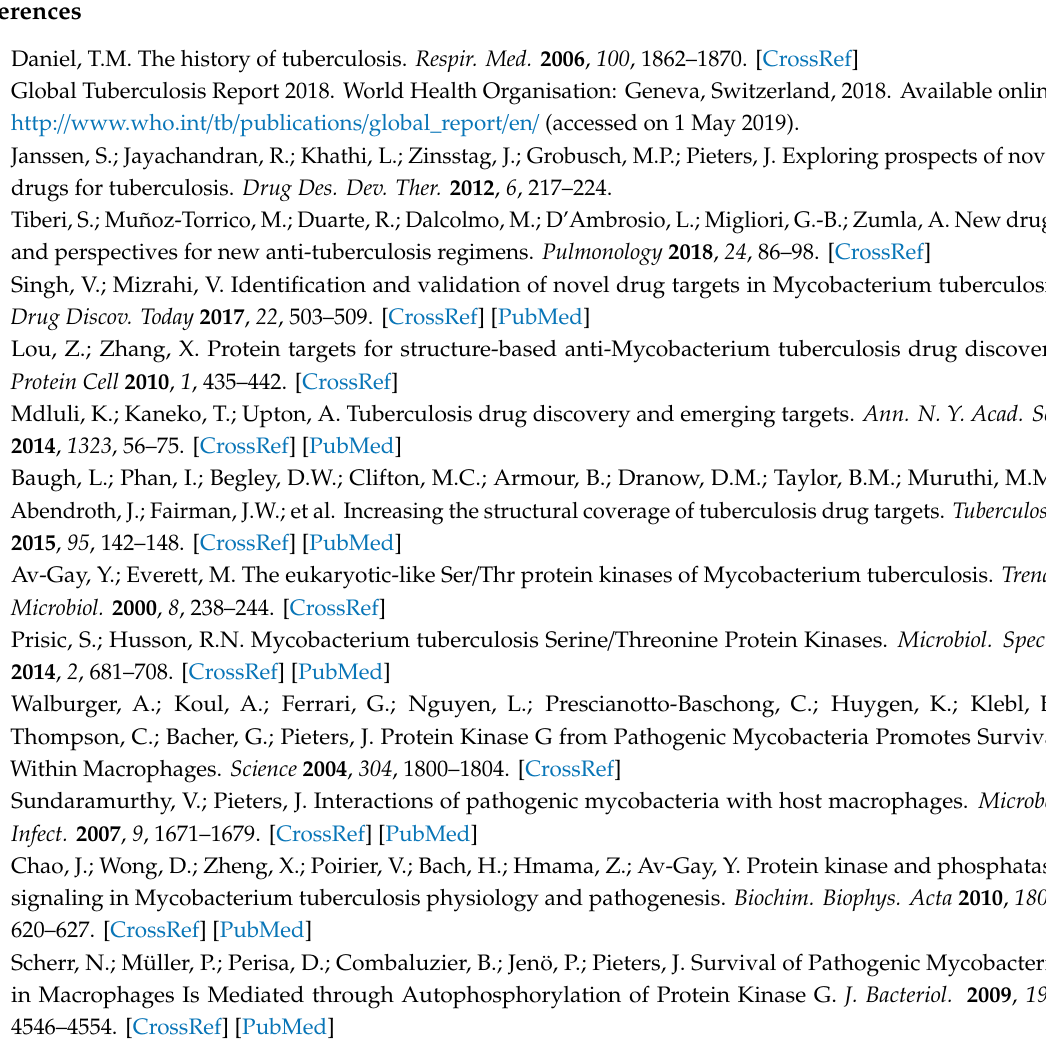
Figure S1: Docked pose of nicotiflorin (3) in the Mt PknG binding site showing molecular interactions—hydrogen-bondsasgreendashedlinesandhydrophobicbondsaspink / purpledashedlines—between (3) and Mt PknG, generated by BIOVIA Discovery Studio visualizer, Figure S2: Docked pose of orientin (4) in the Mt PknG binding site showing molecular interactions—hydrogen-bonds as green dashed lines and hydrophobic bonds as pink / purple dashed lines—between (4) and Mt PknG, generated by BIOVIA Discovery Studio visualizer, Figure S3: Docked pose of populnin (5) in the Mt PknG binding site showing molecular interactions—hydrogen-bondsasgreendashedlinesandhydrophobicbondsaspink / purpledashedlines—between (5) and Mt PknG, generated by BIOVIA Discovery Studio visualizer, Table S1: Origin of Pelargonium natural products and their predicted free binding energy (docking score ∆ G in kcal / mol) and ligand e ffi ciency indices towards Mt